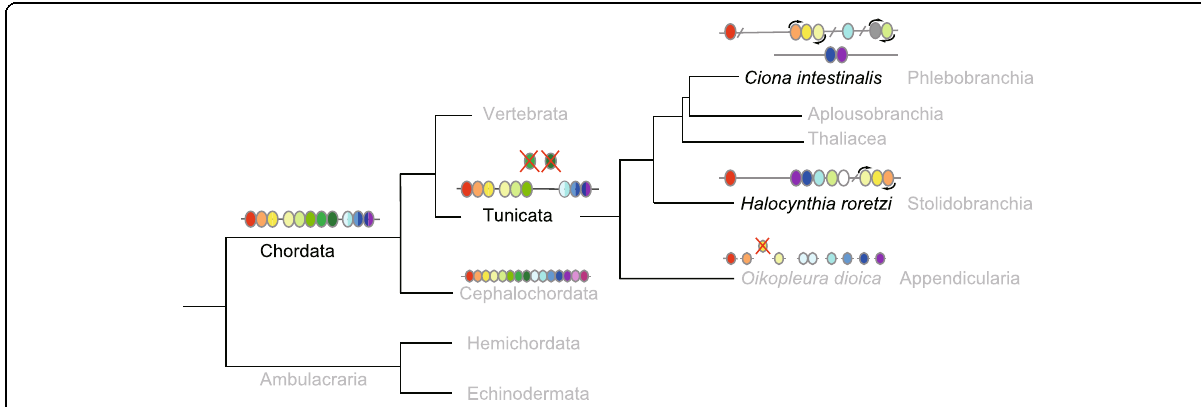
Fig. 5R A proposed scheme for Hox gene cluster disintegration during ascidian evolution. The last common ancestor for cephalochordates, tunicates, and vertebrates (represented as Chordata) possessed a single Hox gene cluster consisting of three anterior (red, orange, and yellow), five central (green) and three ancestral posterior genes (blue). After the ancestral cephalochordate diverged, the tunicate ancestor (represented as Tunicata), in turn, diverged from the vertebrate lineage. At this stage, the ancestral tunicate must have experienced extensive changes in the genome, and the Hox gene cluster disintegration started, losing one or two central Hox genes. The ancestral tunicate subsequently evolved, being separated from Appendicularia, into two lineages; one leading to stolidobranchian ascidians (Hr) (right side, middle) and the other leading to phlebobranchian (Ci) and aplousobranchian ascidians as well as Thaliacea (right side, upper) [33, 34]. By the divergence of the two evolutionary lineages, the Hox gene complement of the ancestral ascidian with each three of anterior, central and posterior genes must have been established. At the same time, early Hox gene cluster disintegration events must have occurred. Then, the Hox gene cluster further disintegrated in different patterns in the evolutionary lineages giving rise to Hr and Ci. White or gray ovals indicate Hox genes, probably of the central Hox gene group origin (see text). The Hox gene complement of Oikopleura dioica , consisting of two anterior, one central, and six posterior genes, and that of amphioxus, consisting of 15 members, are schematically